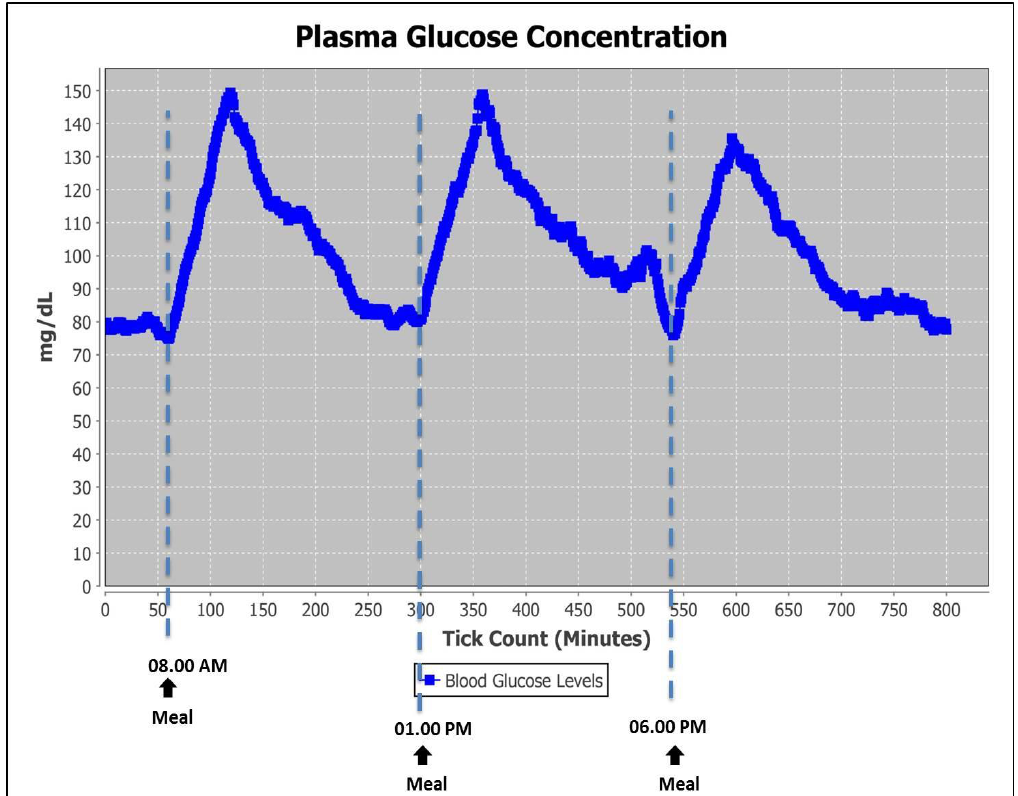
Figure 4. Regulation of blood glucose levels after a